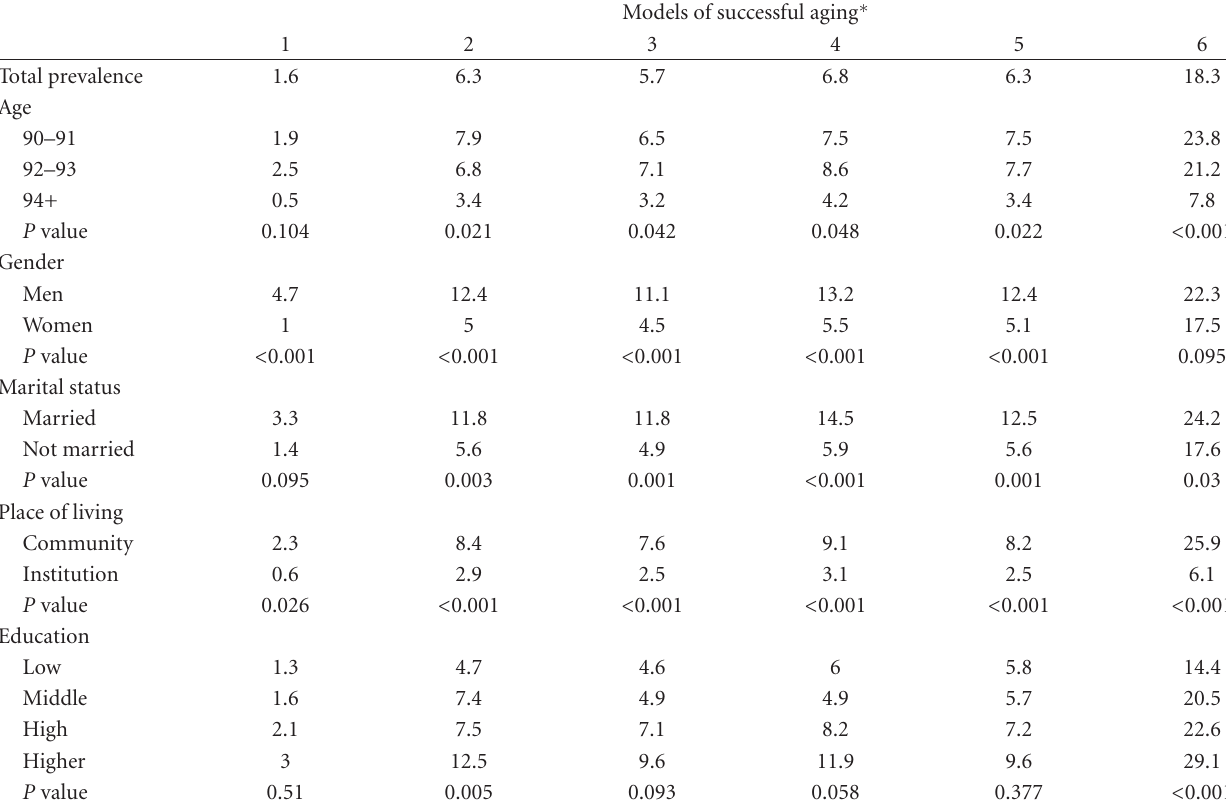
Table 3: Prevalence of successful aging (%) according to the six models in di ff erent socioeconomic categories. Models of successful aging